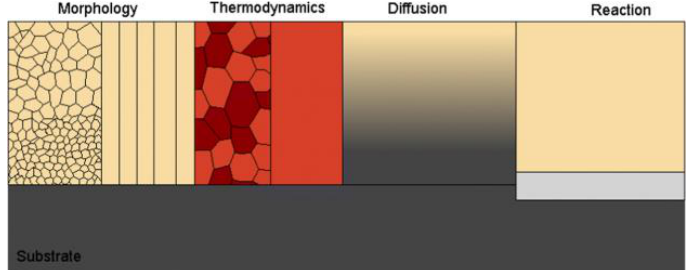
Figure 23. Schematic representation of factors that are affected by the substrate temperature during the thin-film deposition of garnet-structured electrolytes. Reproduced with permission from [352]. Copyright 2018 Springer.